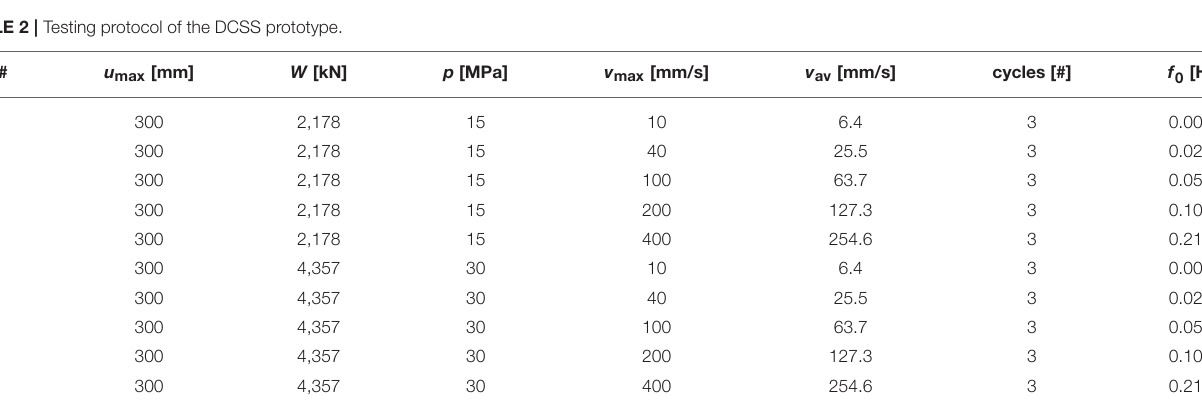
TABLE 2 | Testing protocol of the DCSS